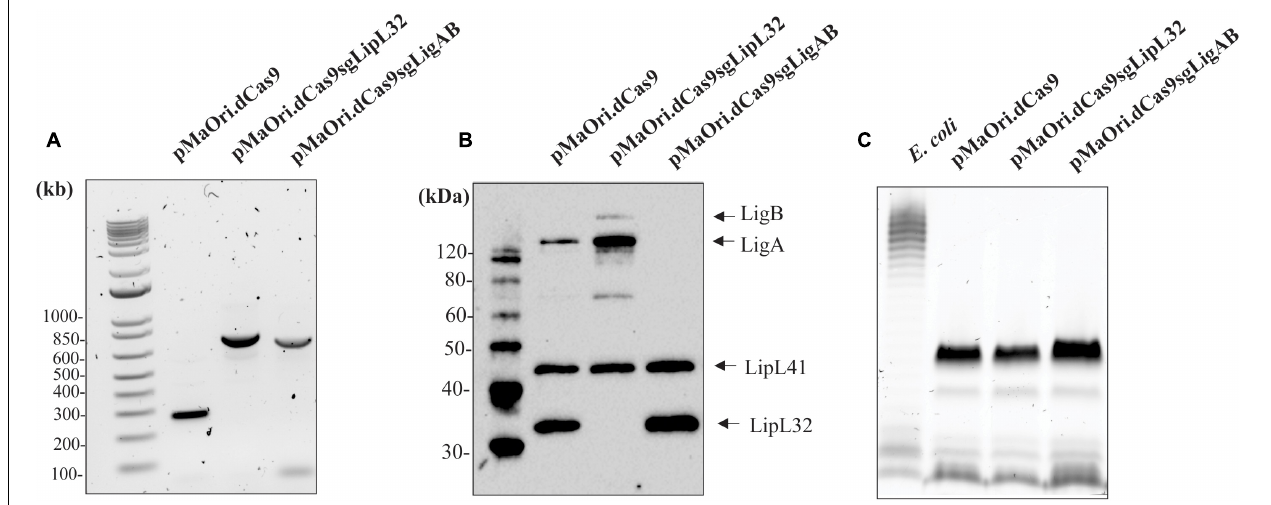
FIGURE 1 | Confirmation of knockdown LigAB and LipL32 mutagenesis. (A) Depicts the presence of the empty pMaOri.dCas9 plasmid and the cassettes containing the sgRNA targeting lipL32 and ligAB by PCR with primers flanking the sgRNA cassette. (B) Representative immunoblot of 5 × 10 7 recombinant cells containing empty pMaOri.dCas9 plasmid alone or with sgRNA for LipL32, and LigAB, which have been probed with antisera specific for LigA/B, LipL41, and LipL32. (C) Staining for LPS in 5 × 10 7 recombinant cells containing empty pMaOri.dCas9 plasmid alone or with sgRNA for LipL32, and LigAB. LPS from E. coli serotype 055:B5 was used as a positive control. Molecular mass markers (M) (kDa) are indicated in panels (A,B) .